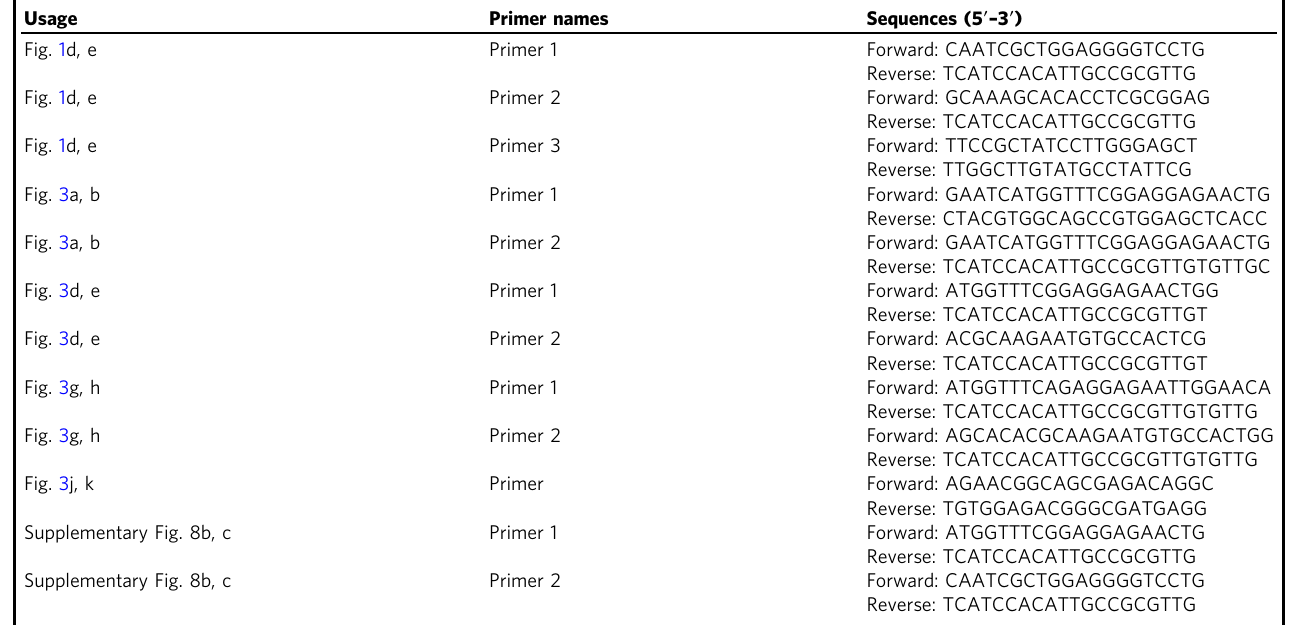
Table 2 Primers used for RT-PCR experiments.